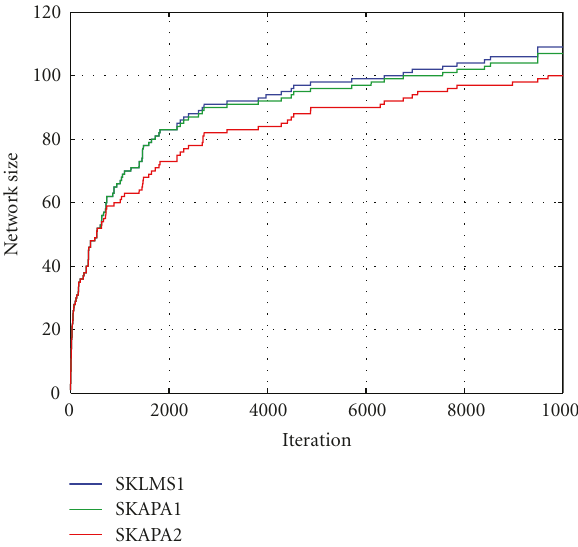
Figure 7: Network size over training in the nonlinear channel